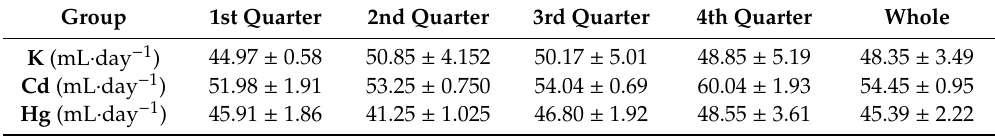
Table 4. Average water intake of male rats ±